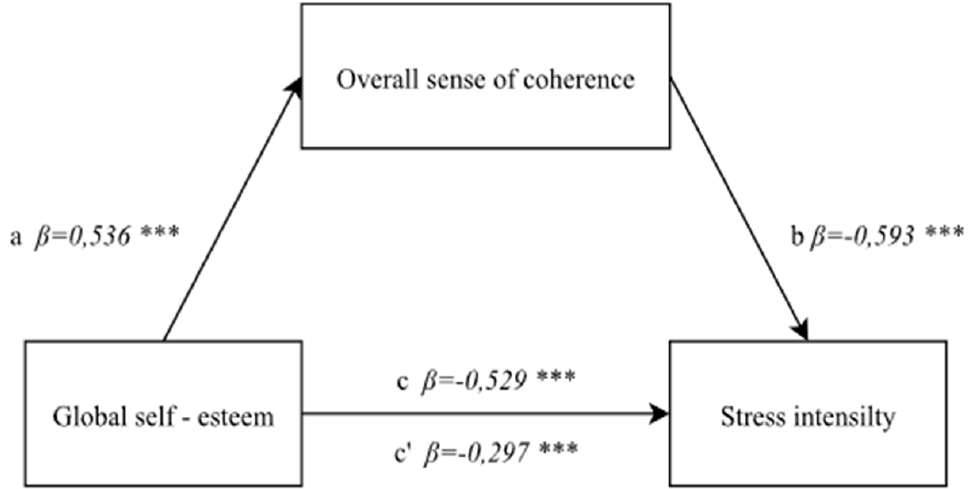
Figure 2. Model of a mediatory role of a general sense of coherence between global self-esteem and stress intensity . Statistically significant: *** p < 0.001.